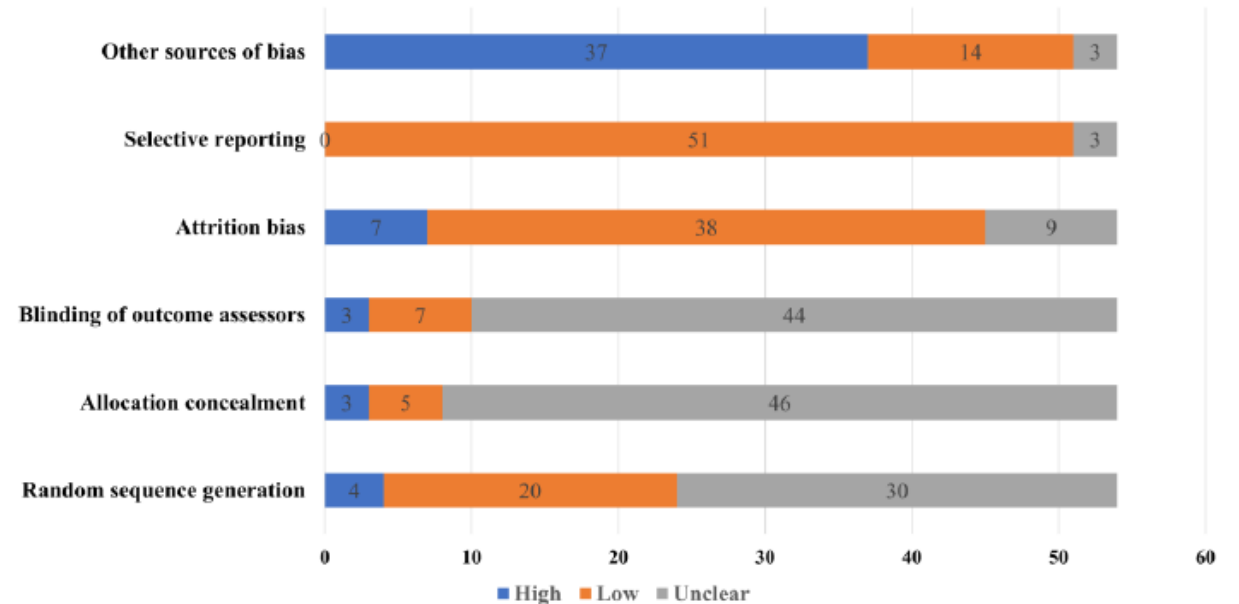
Figure 8. Summary graph for risk of bias among included RCTs.